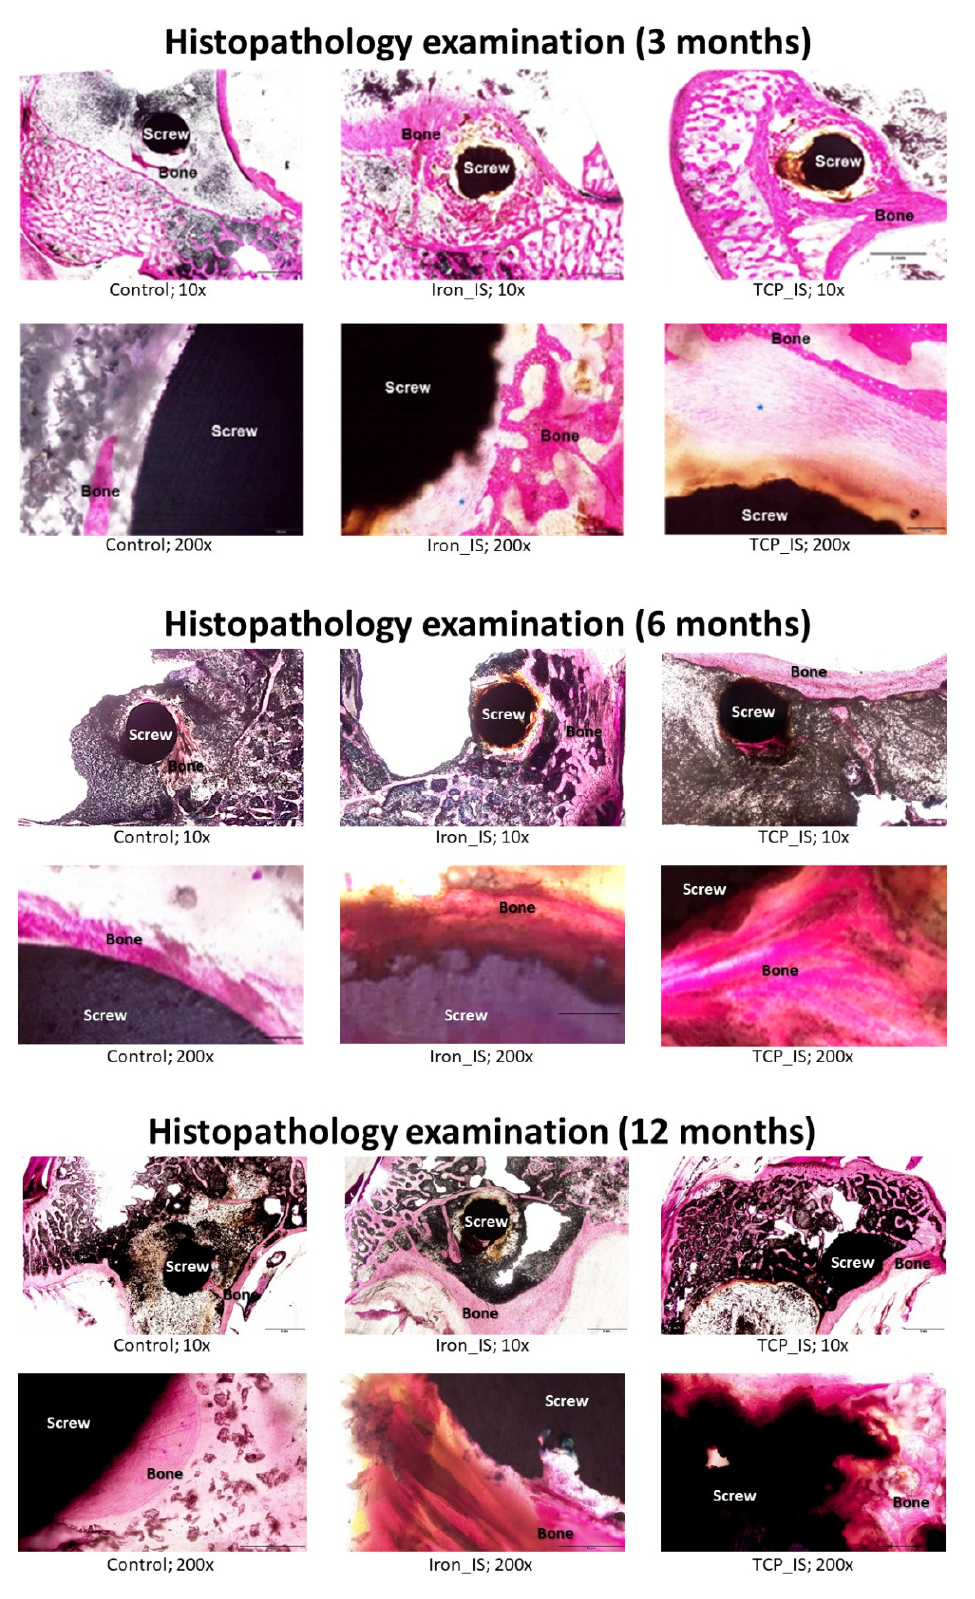
Figure 7. Histopathological examination of the bone–tendon–screw complex at months 3, 6, and 12 af- ter implantation. Specimens were stained with Sanderson’s rapid bone stain and then counterstained with acid fuchsin.